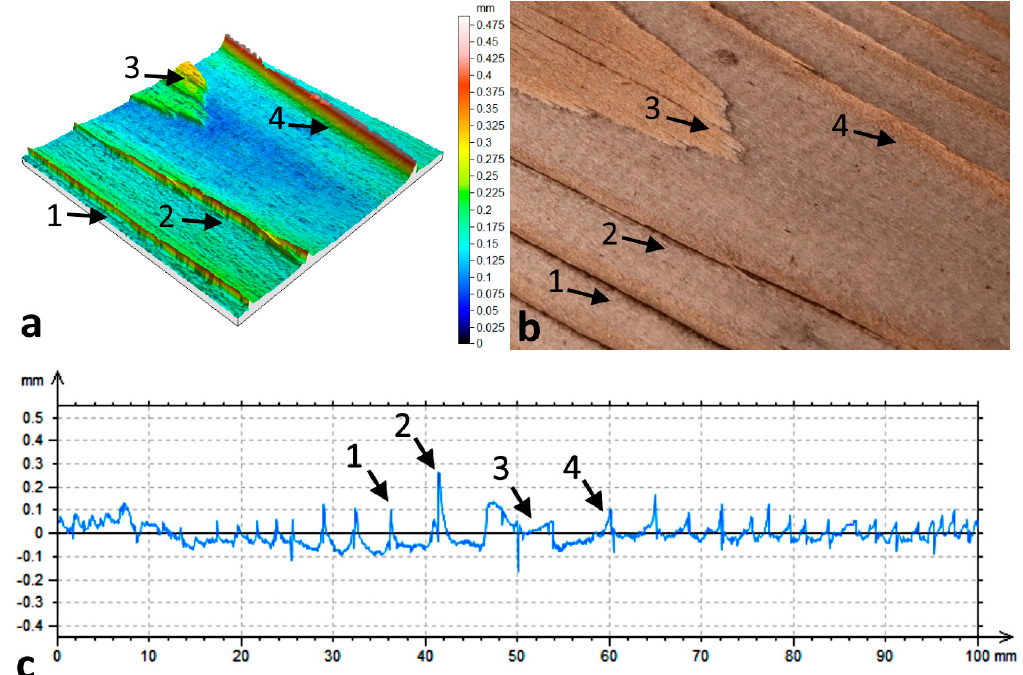
Figure 2. Shelling of growth rings in a flat western larch deckboard oriented pith-side-up and exposed to the weather for 7 months in Vancouver, BC, Canada. Four shelled growth rings including a shelled latewood tip are labelled, 1, 2, 3, and 4: ( a ) confocal profilometry height map showing four shelled growth rings; ( b ) photograph of four shelled growth rings matching the height map in Figure 2a; and, ( c ) confocal profilometry line scan showing the heights of the shelled growth rings in Figure 2a,b.